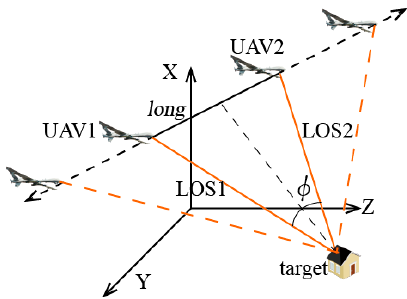
Figure 7. Positional relationship between UAVs and the target.